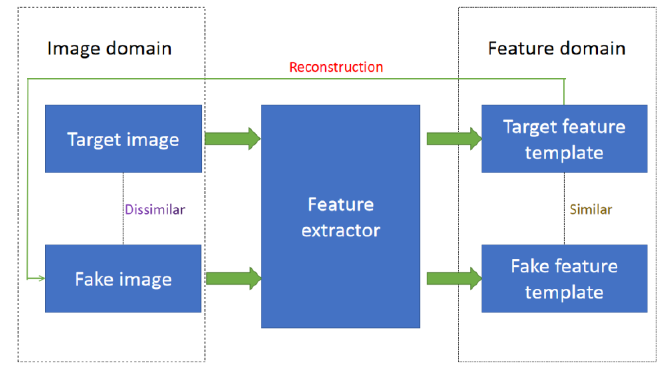
Figure 1. Reconstruction attack.